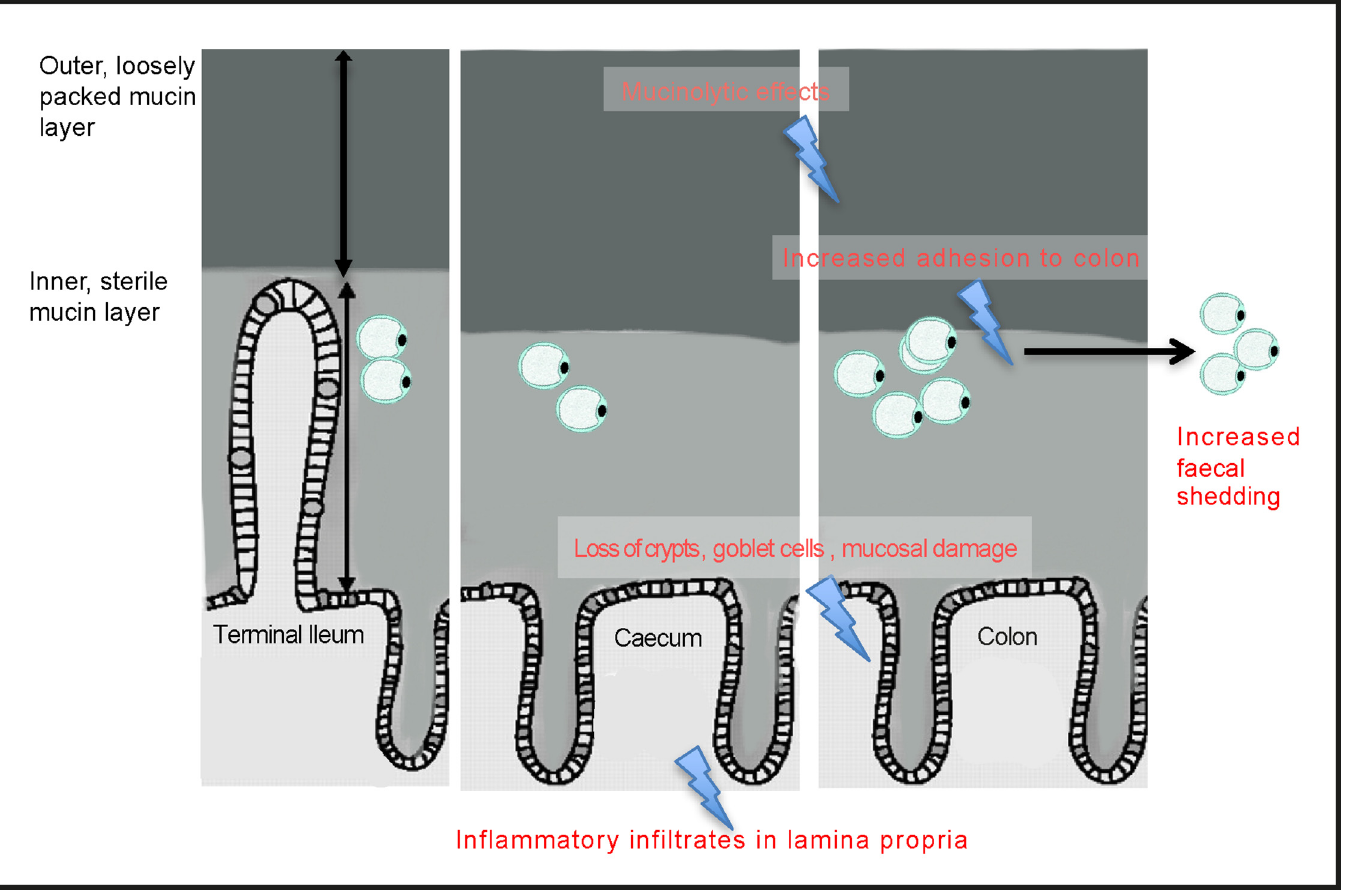
Fig 6. Model of adhesion and colonization: Blastocystis spp. are luminal, mucin binding and mucinolytic. ST7-H is more adhesive than ST7-B and shows tissue tropism to colon. Increased adhesiveness results in better colonization in DSS treated susceptible mice with a longer duration of shedding and increased tissue damage and